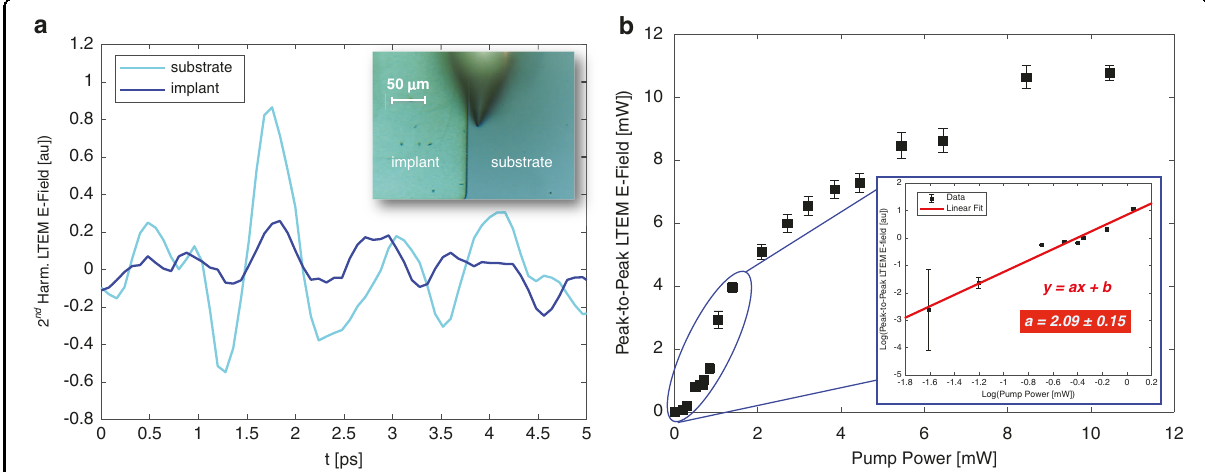
Fig. 3 Terahertz emission from Si sample. a Near- fi eld THz emission waveforms from a blue light pump, emitted by the Si substrate (light blue) and implanted region (dark blue). Inset: top-down AFM camera view of the implant-substrate boundary region. b Peak-to-peak far- fi eld THz emission amplitude from the Si substrate region vs. 410 nm pump average power. Inset: log-log plot of low powers. Linear fi t shows quadratic E - fi eld vs. pump power behavior, suggesting the dominant mechanism of THz emission is two-photon